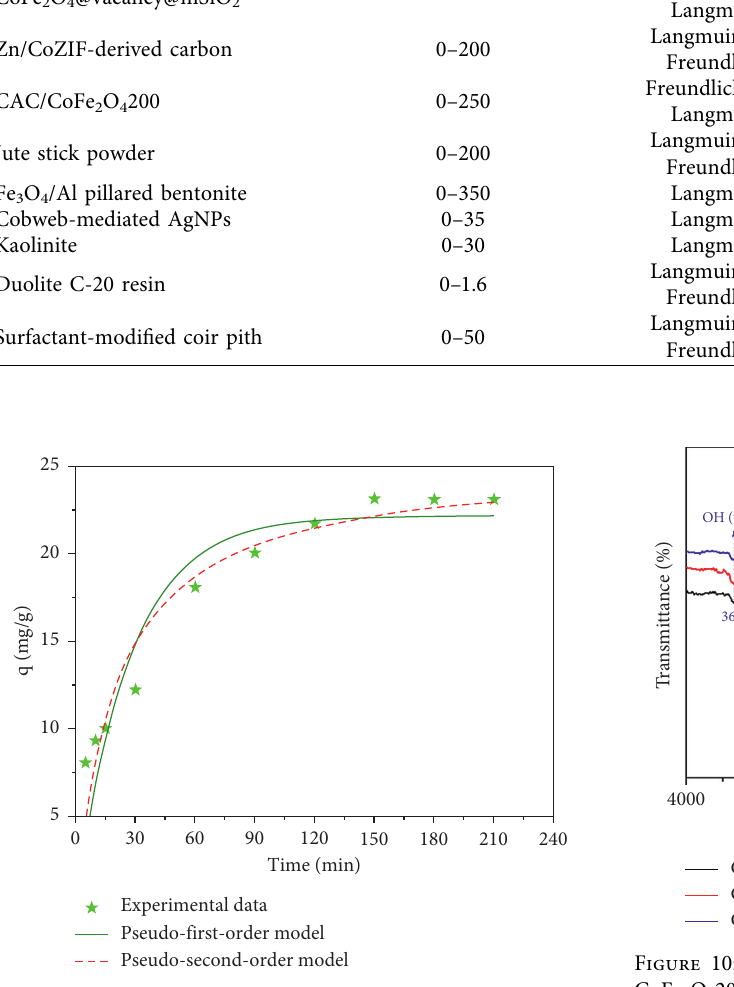
Figure 9: Kinetic models of RhB adsorption onto CAC/ CoFe 2 O 4 200 with the initial RhB concentration of 50mg/L, ad- sorbent dosage of 0.05mg/25mL, and initial pH of 4.